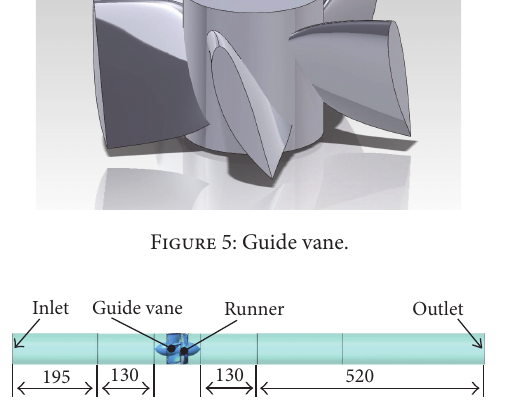
Figure 6: Computational